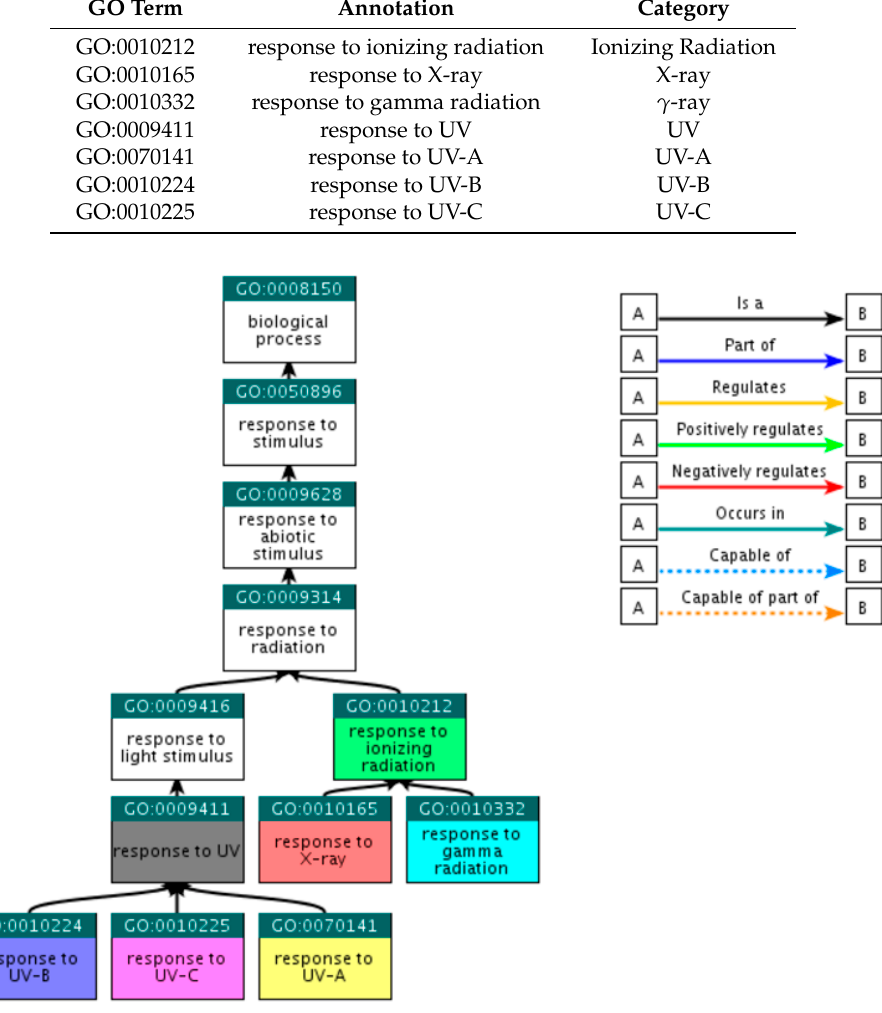
Table 1. Table 1. Selected Gene Ontology (GO) terms, their description and the component of the electromagnetic spectrum they represent.